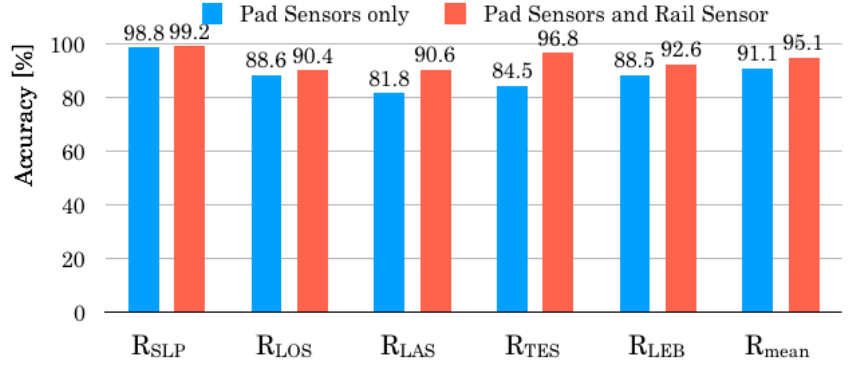
Figure 15. Comparison results of recognition